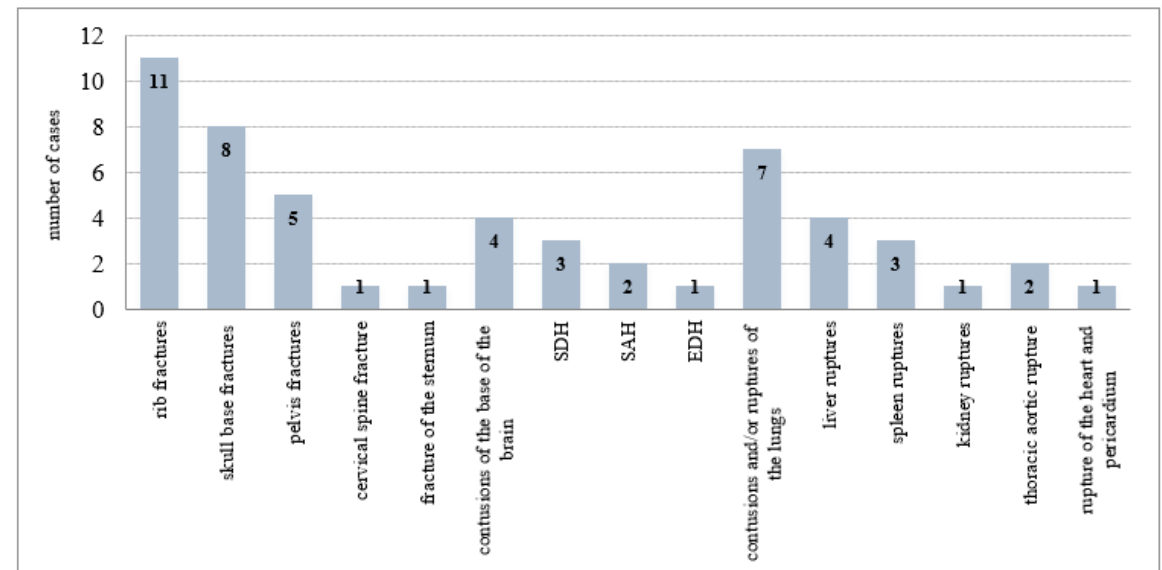
Figure 3. ( A ) The false negative cases of CT scans (73) for each type of injury. SDH—subdural hem-